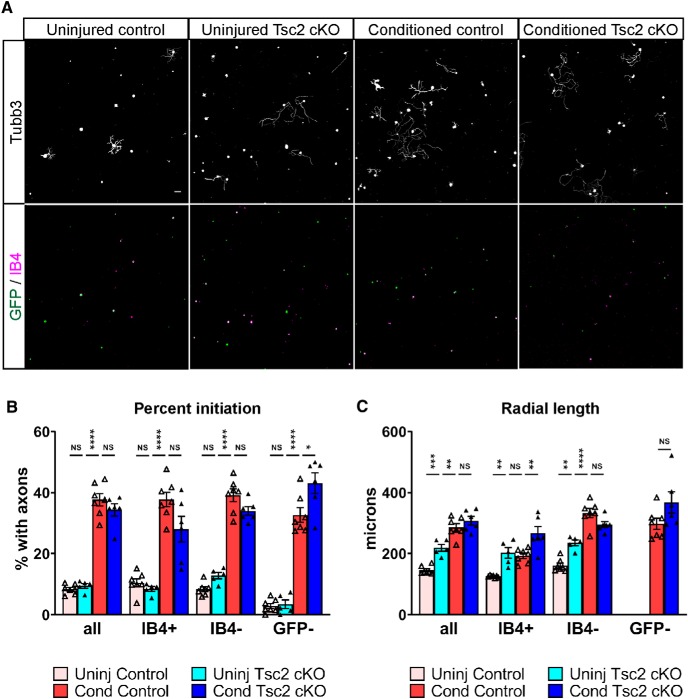
Nociceptor deletion of Tsc2 increases axon length but not percentage initiation in cultured neurons. A, Uninjured and injury-conditioned (3 d) L4 DRG neurons from control and Tsc2 cKO mice crossed with Rosa26-ZsGreenGFP/+ cultured for 24 h and stained for neuronal tubulin (Tubb3) and IB4. Scale bar: 50 μm. B, C, Quantification of the percentage of cultured neurons that grow axons (B) and the radial length of those axons (C) from A. Radial length of uninjured GFP– neurons is not reported due to the number of neurons growing axons being too low to be representative. N.S., not significant, *p < 0.05, **p < 0.01, ***p < 0.001, ****p < 0.0001. Extended Data Figure 7-1 shows data values of mean and SEM, number of replicates, statistical tests, and values for all comparisons.